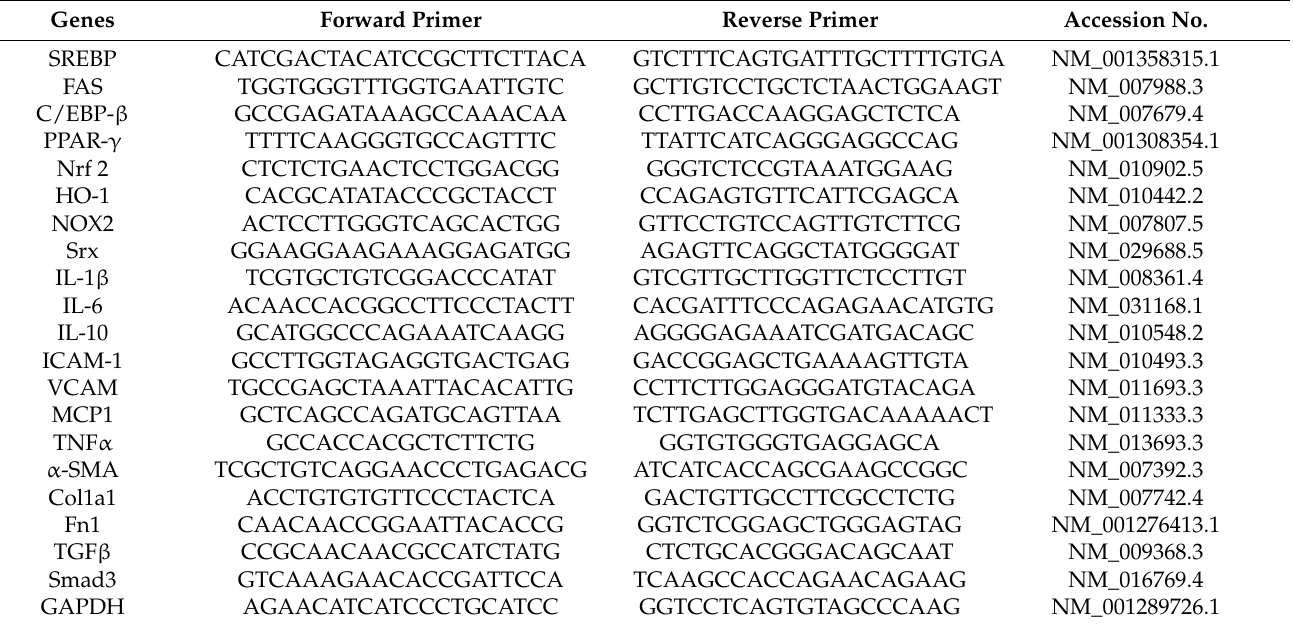
Table 1. Primer sequences of target genes for real-time reverse transcription polymerase chain reaction